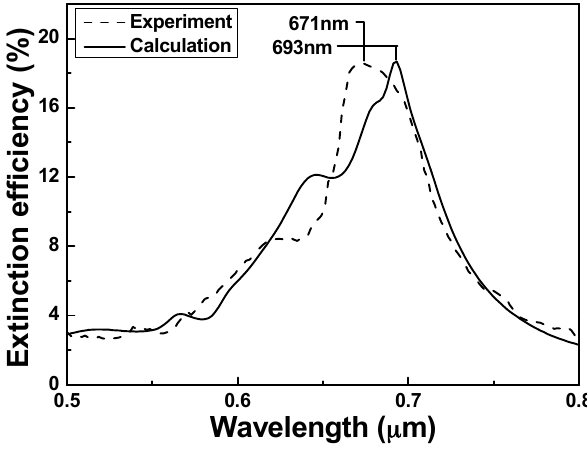
Figure 9. Localized surface plasmon resonance (LSPR) spectra comparing the simulation result and the measured response of hexagonal lattice of triangular periodic nanoparticle arrays.